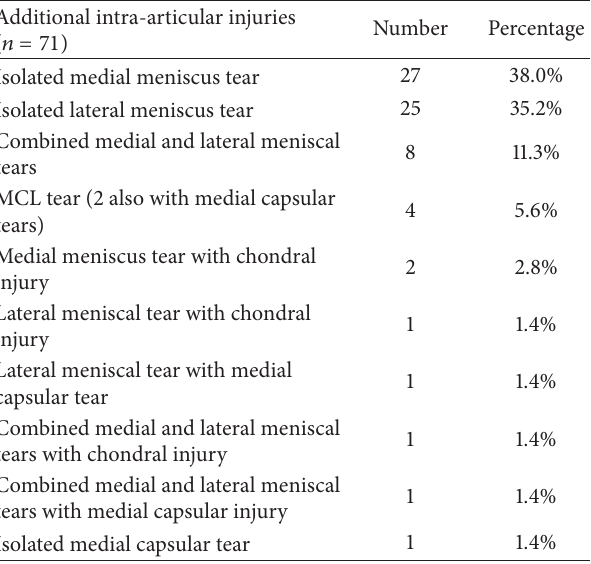
Table 4: Distribution of additional intra-articular